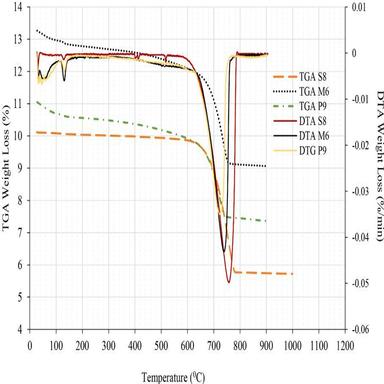
TGA/DTG curves for representative stone, mortar and plaster samples.